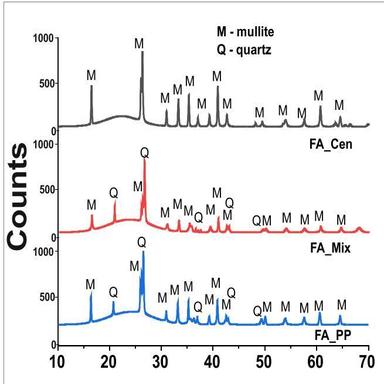
X - ray diffraction patterns recorded for FA_Cen, FA_Mix and FA_PP samples.